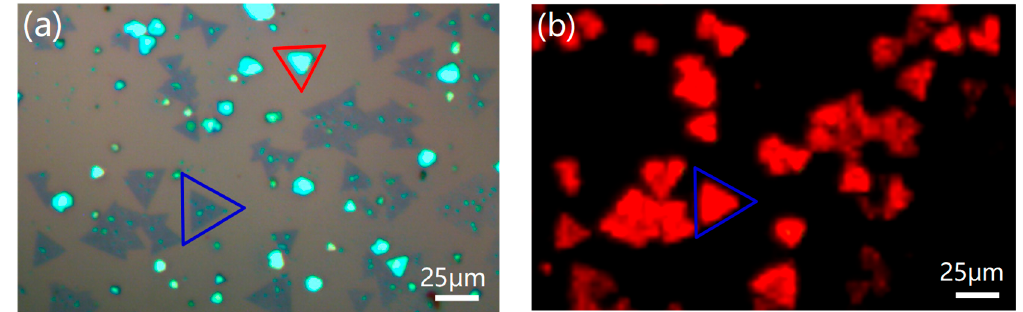
Figure 3. ( a ) Optical microscopy image of WS 2 monolayer (marked with a blue triangle) and multilayer (marked with a red triangle). ( b ) The photoluminescence (PL) image corresponding to the sample ( a ). ( a , b ) are taken at the same location. The pattern with red color in ( b ) is due to the PL emission of monolayer WS 2 .